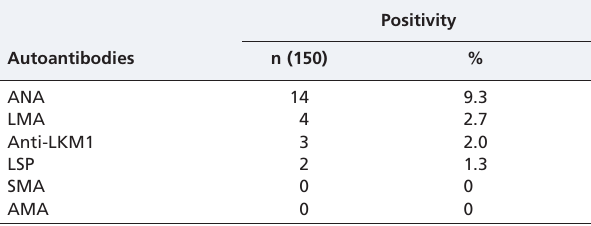
Table 2 - Liver autoantibodies positivity (%) in